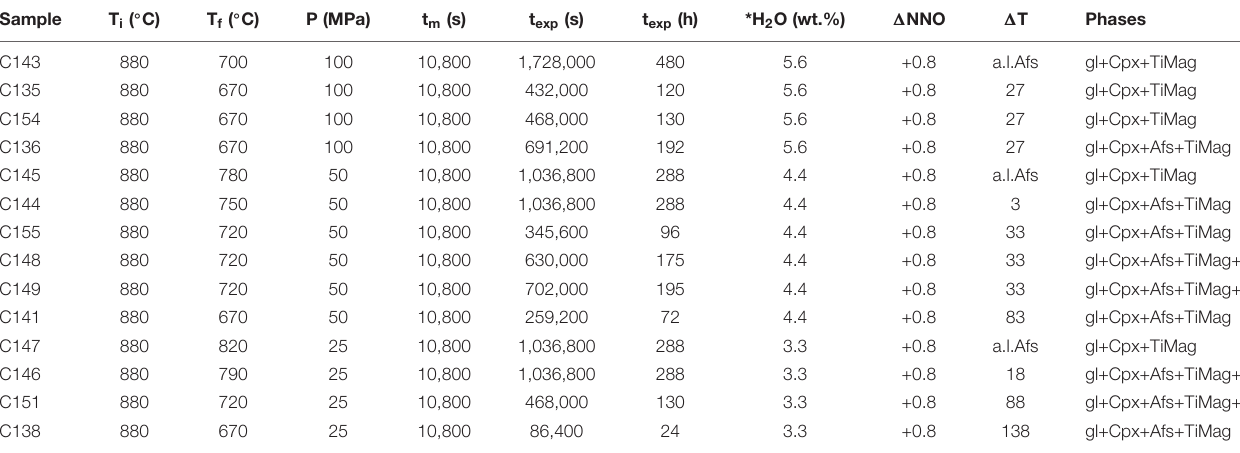
TABLE 2 | Experimental conditions of water-saturated experiments. Sample